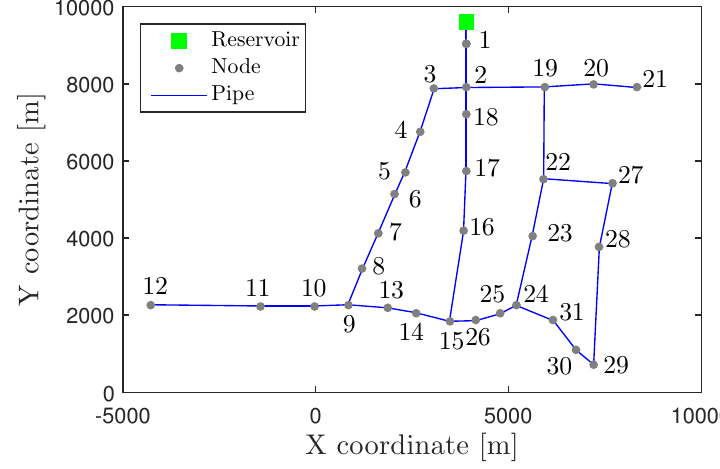
Figure 2. Simplified Hanoi topological